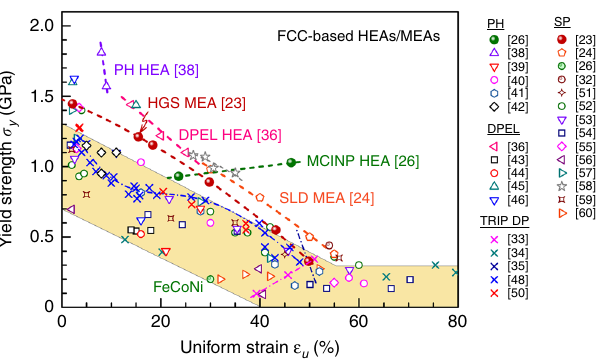
Fig. 3 Yield strength versus uniform tensile strain in FCC-based HEAs. Four types of microstructures are summarized in the plot. A few high- performance examples above the yellow band are marked with acronyms and references. Precipitation hardened (PH): two examples are highlighted using green solid circles 26 and open violet triangles 38 , while the rest cases are shown with open symbols. Dual-phase eutectic structure: a representative of this group is the dual-phase eutectic lamellae (DPEL) in ref. 36 . TRIP metastable dual-phase (DP): all × symbols, e.g., ref. 33 . Single- phase (SP) FCC: highlighted in red solid and open circles are the HGS- CoCrNi MEA 23 and the VCoNi MEA with severe lattice distortion (SLD) 24 , respectively; the rest in this SP group is shown with open